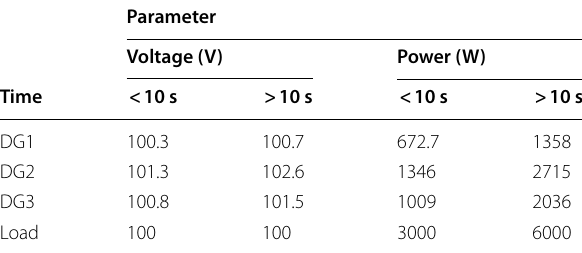
Table 3 System data primary and secondary control